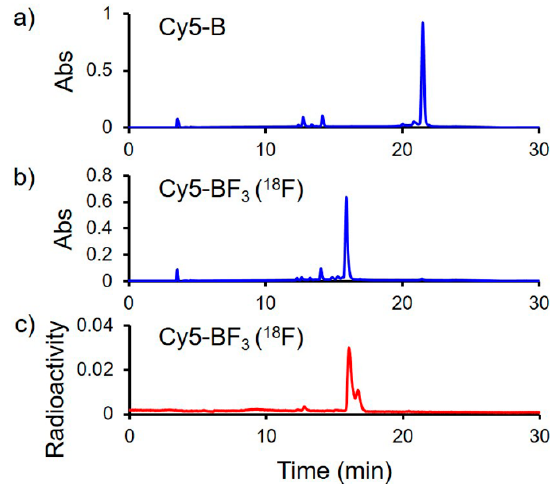
Figure 3. ( a ) The HPLC shift of the Cy5-B in the absorption channel of 650 nm wavelength; ( b ) The HPLC shift of the Cy5-BF 3 ( 18 F) in the absorption channel of 650 nm wavelength; ( c ) The HPLC shift of the Cy5-BF 3 ( 18 F) in the radioactivity channel of Cy5-BF 3 ( 18 F). C18 Reversed Phase LC Column (Waters, SunFire C18 Column, 100 Å, 3.5 µm, 3 mm × 100 mm, water/acetonitrile: 90/10 to 10/90, 20 min, ultrapure water and HPLC acetonitrile (Sigma, St. Louis, MO, USA)).